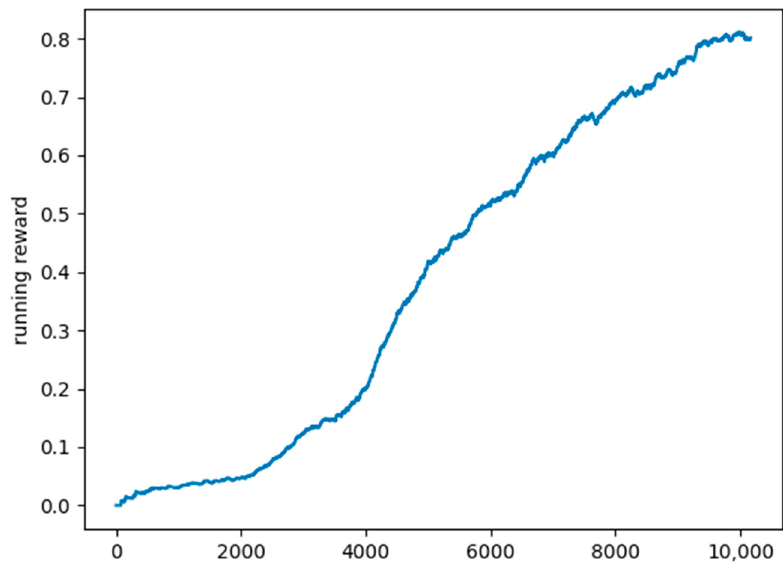
Figure 6. Plot of the mean running reward.